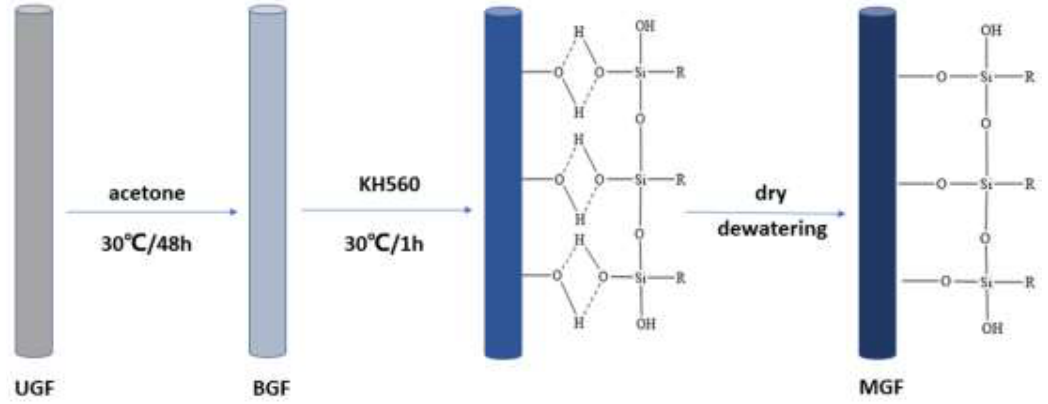
Figure 1. Glass fibre modification.